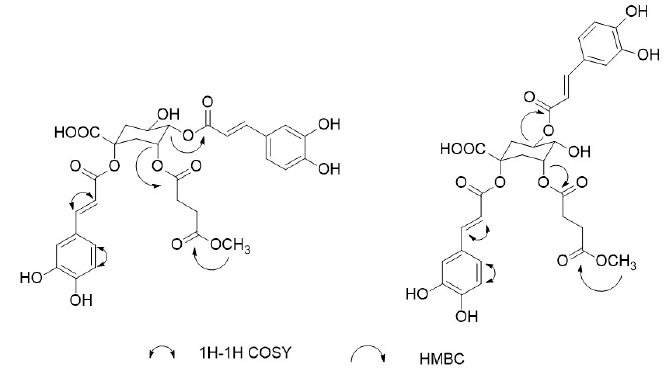
Figure 3. Key HMBC and 1 H- 1 H COSY correlations of new Figure 4. Key HMBC and 1 H- 1 H COSY correlations of new compounds.